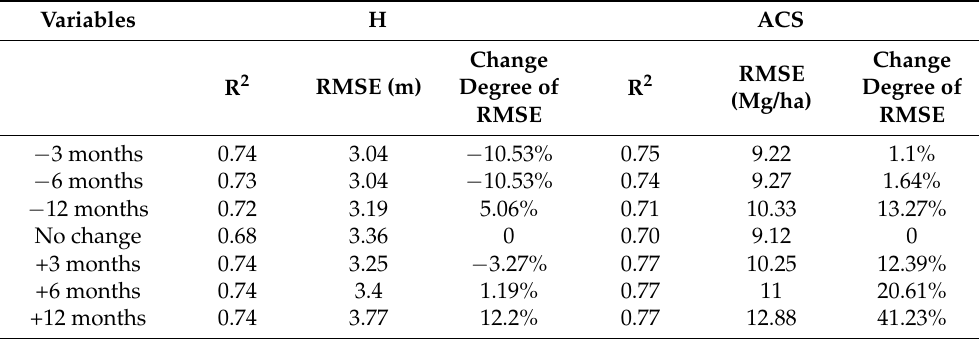
Table 4. Comparison of model predicted height (H) and aboveground carbon stocks (ACS) with lidar inverse H and ACS under different stand age conditions based on FSC